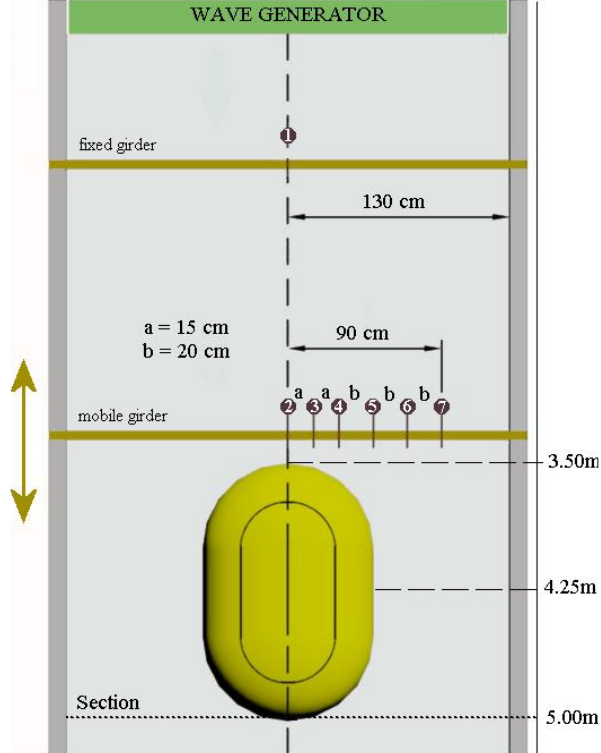
Fig. 1: Experimental set-up.